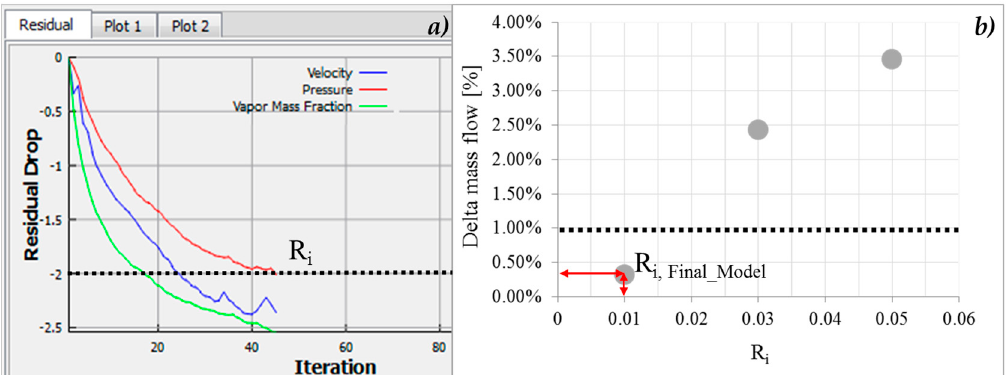
Figure 9. ( a ) Pressure, velocity and vapor mass fraction—residual drop analysis R i ; ( b ) error on the mass flow vs residual drop R i .